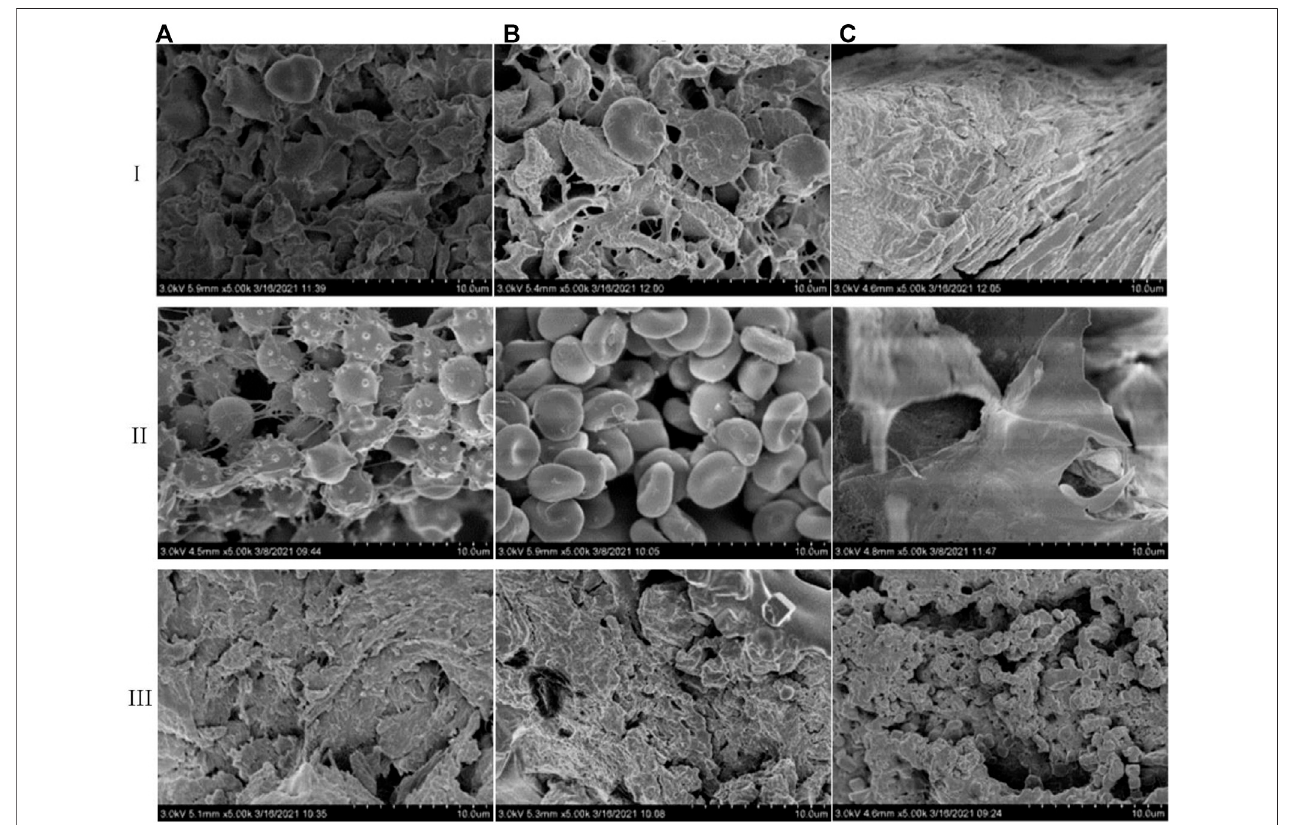
FIGURE 6 | Comparison of action modes of three hemostatic materials on whole blood (i), blood cells (ii), and platelets (iii) ( ✕ 5K) (A) . Fish collagen (B) . Bovine collagen (C) . Oxidation regeneration of cellulose).